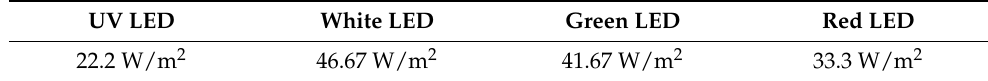
Table 1. The light intensity of various LED sources.